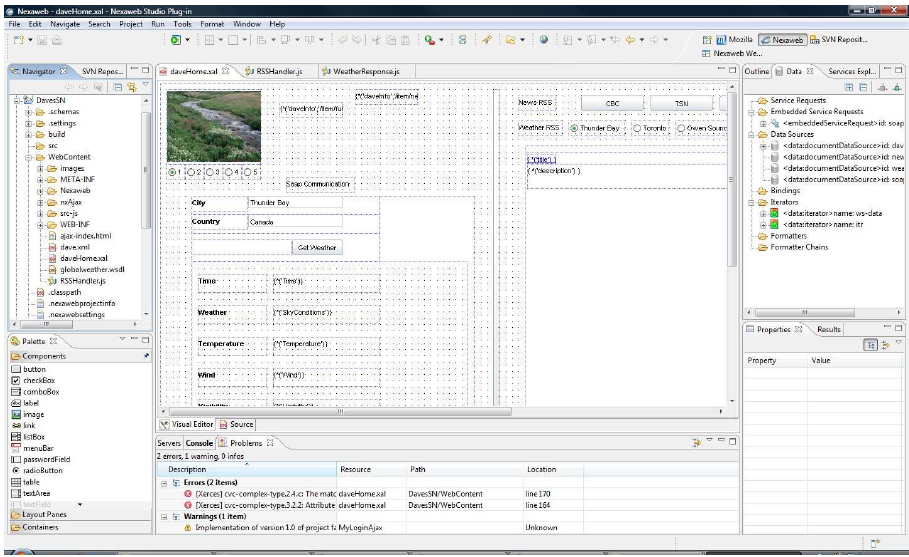
Figure 5. Using the Nexaweb Studio to Design a Weather Mashup